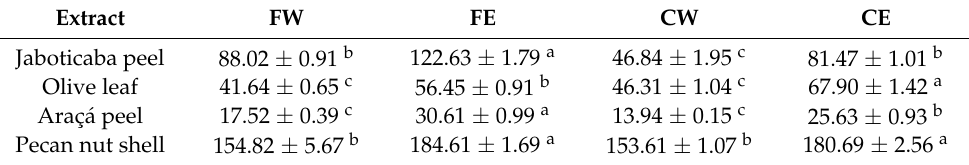
Table 3. Total phenolic compounds (mg GAE g − 1 , d.w.) of the natural extracts. Extract FW FE CW CE Jaboticaba peel 88.02 ± 0.91 b 122.63 ± 1.79 a 46.84 ± 1.95 c 81.47 ± 1.01 b Olive leaf 41.64 ± 0.65 c 56.45 ± 0.91 b 46.31 ± 1.04 c Pecan nut